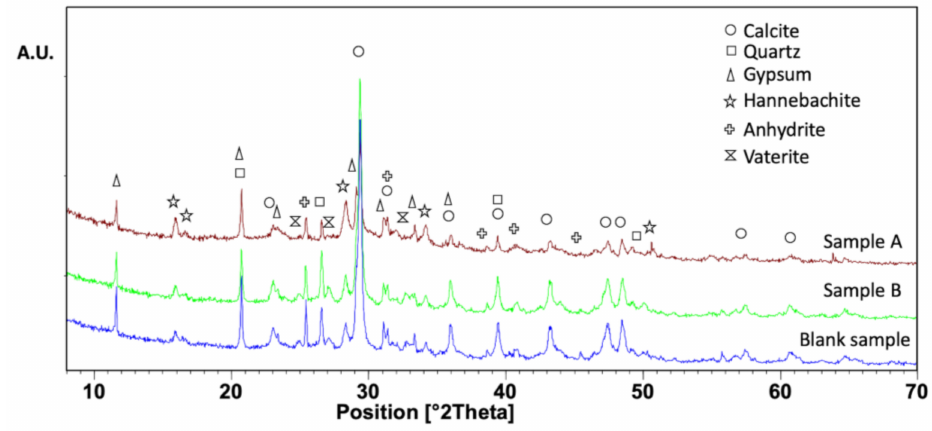
Figure 2. The XRD spectra of adsorbent materials: sample A, sample B, and a blank